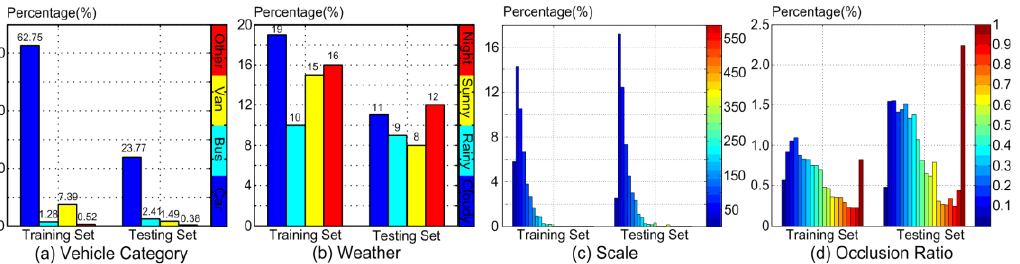
Figure 8. Shows the overall distribution of the dataset: ( a ) different vehicle types in the labeled dataset; ( b ) different environments in the dataset; ( c ) the scale distribution of the labeled dataset; ( d ) the occlusion ratio of different data.